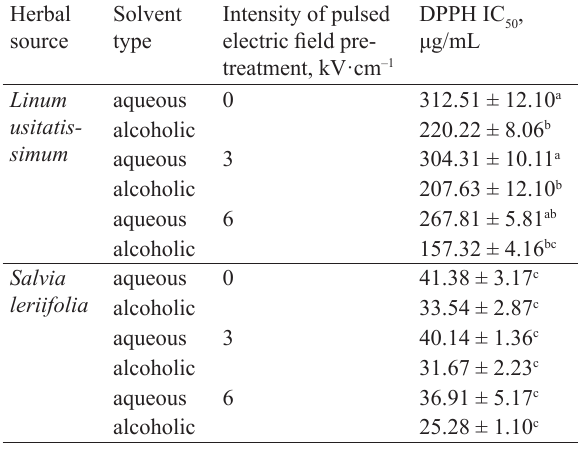
Table 3 Interaction between herbal source, pre-treatment, and solvent type in their effects on antioxidant activity by DPPH method